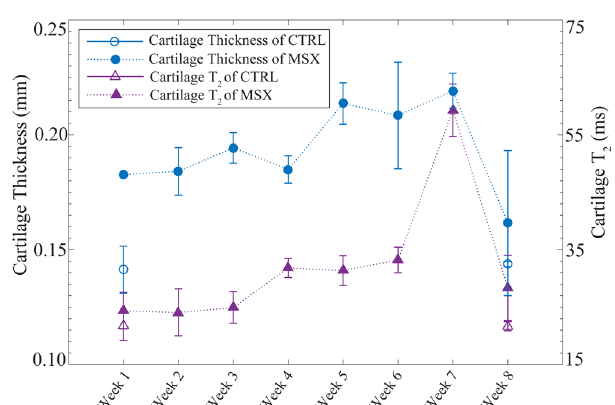
Figure 4. Cartilage thickness and cartilage T 2 evolution of MSX joints over the eight week observation period post meniscectomy. The CTRL data of week 1 and week 8 are also presented here. Cartilage T 2 exhibited little change between week 1 and week 3, as well as between week 4 and week 6. The data represent cartilage from the medial condyle of central coronal slice. Data plotted as mean ±